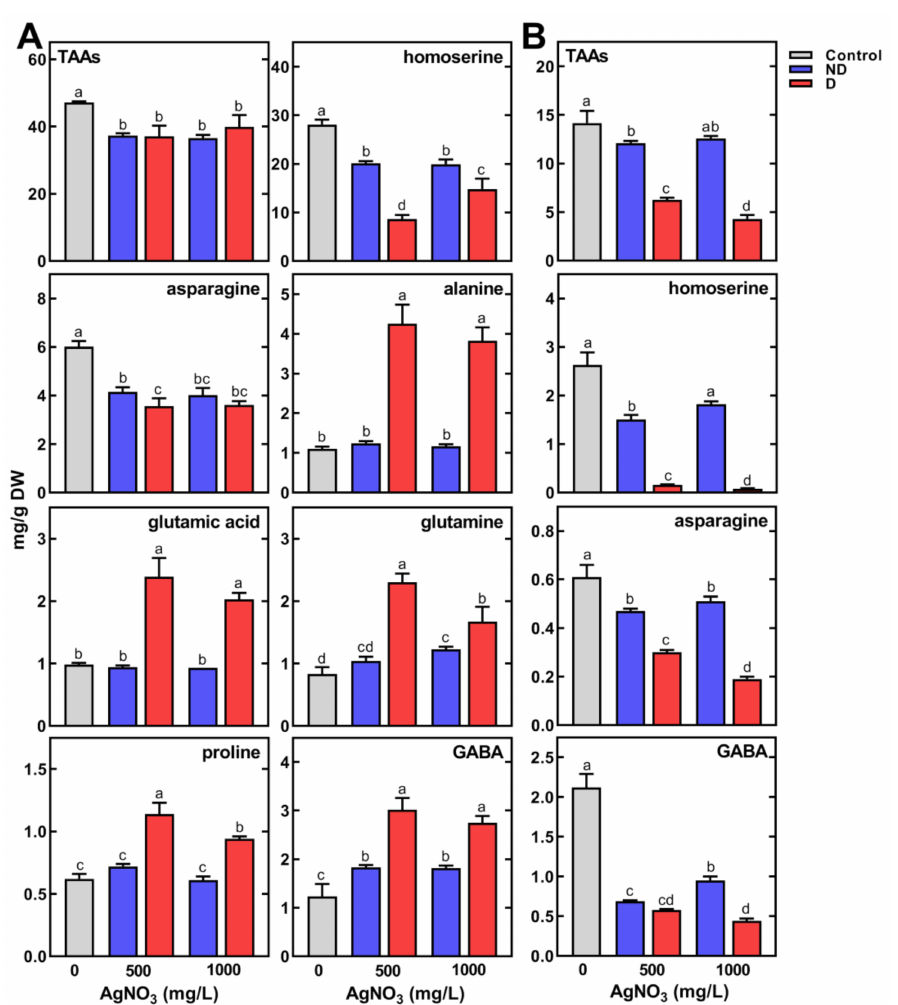
Figure 5. The effect of pea seeds’ imbibition for 8 h with AgNO 3 at concentrations of 0, 500 and 1000 mg/L on the content of total amino acids (TAAs) and selected free amino acids in control, non-deformed (ND) and deformed (D) sprouts ( A ) and cotyledons ( B ) of 4-day-old seedlings. Results are means ( n = 3) + SD. Bars marked with the same letters (a–d) are not significantly different after one-way ANOVA and Tukey post hoc